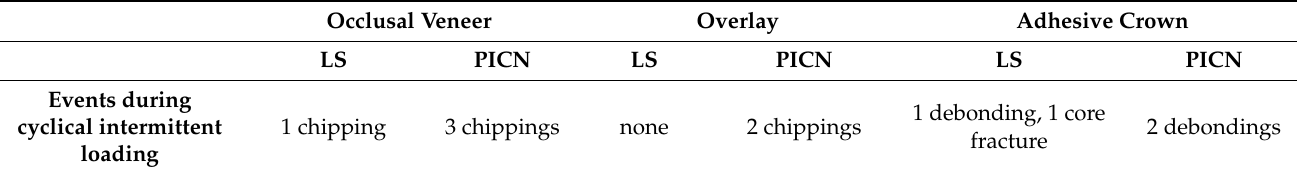
Table 2. Events observed during cyclical intermittent loading.